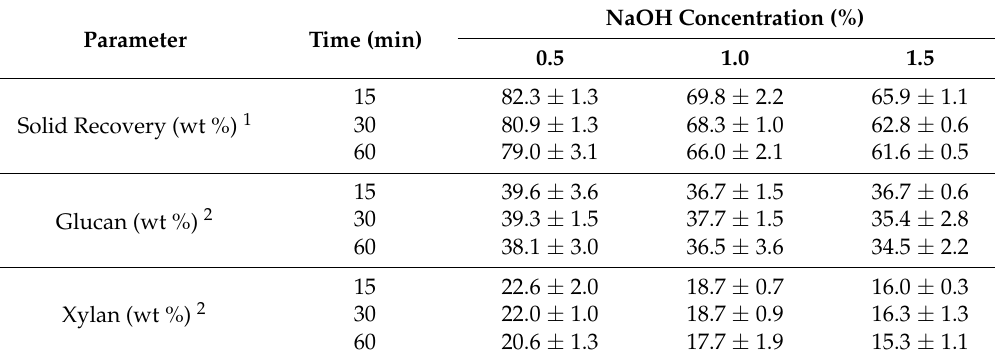
Table 2. Solid recovery, composition of pretreated switchgrass, and delignification after NaOH pretreatment at varying